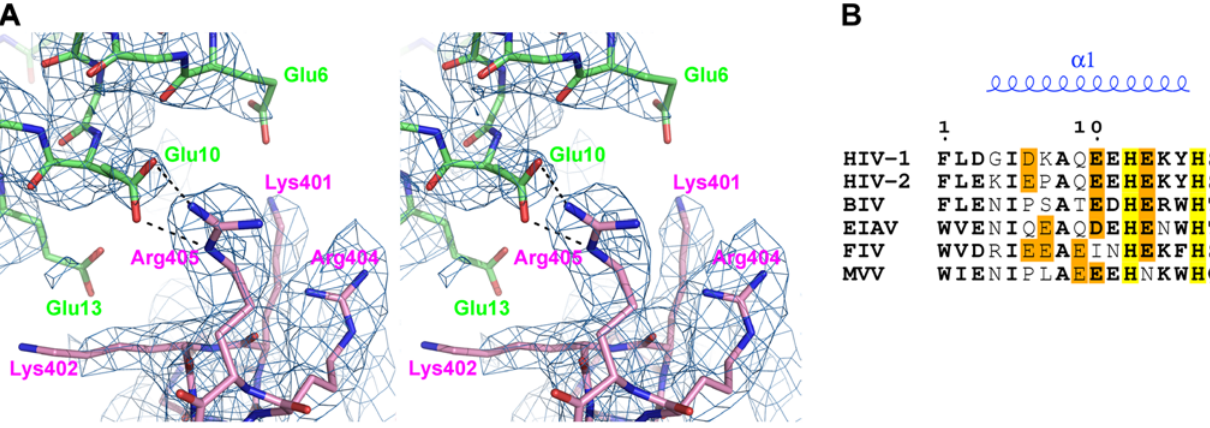
Figure 2. Details of the NTD–IBD Interface. (A) The acidic IN residues and basic LEDGF residues are shown as sticks. The 2Fo-Fc electron density map, contoured at 1 s , is shown in pale blue. (B) Partial amino acid sequence alignment including residues 1–17 of human (HIV-1 and HIV-2) and non- primate (BIV, EIAV, FIV, and MVV) lentiviral INs. Conserved residues are shown in bold; His-12 and His-16 of the invariant HHCC motif are highlighted in yellow. Acidic residues known (for HIV-1 and HIV-2) or proposed to interact with the positively charged face of the IBD are